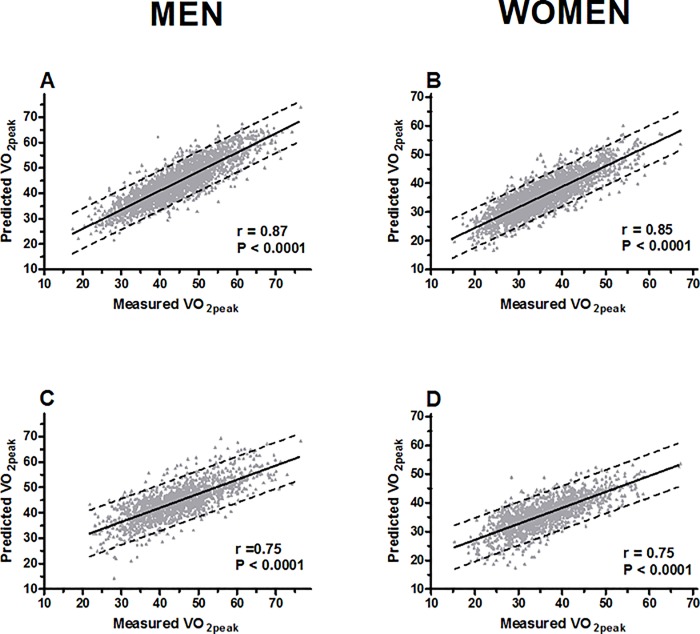
Correlation plots between measured and predicted VO2peak with 95% prediction bands from peak treadmill performance (A and B), and submaximal treadmill performance (C and D).